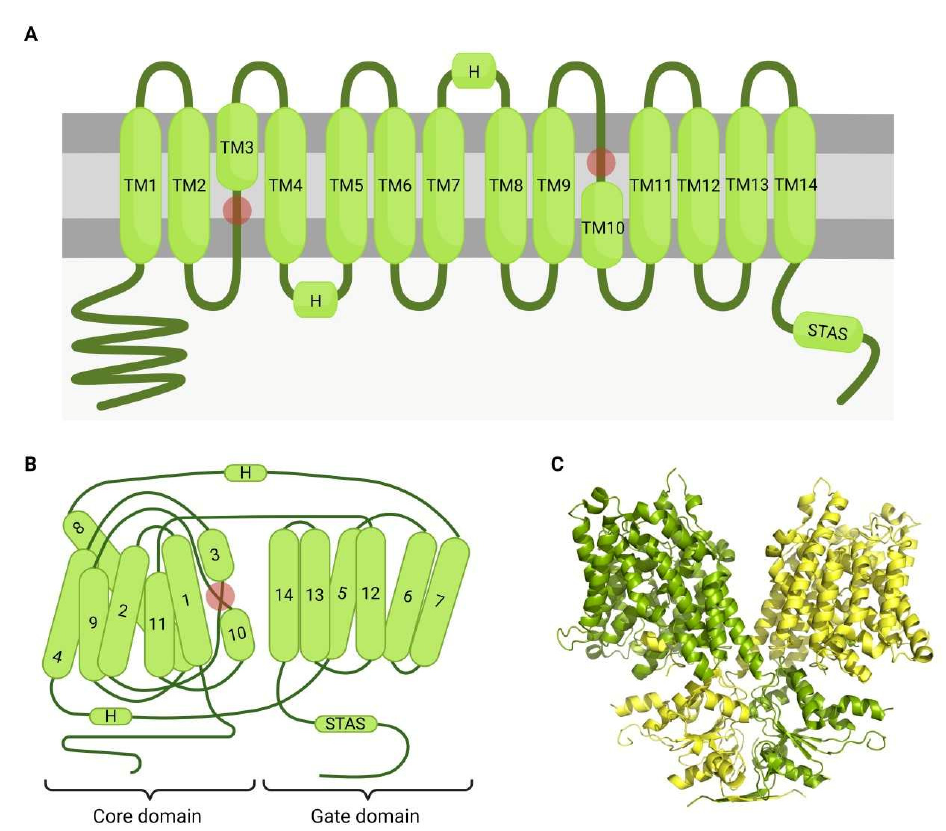
Figure 2. Structural characteristics of SLC26 channels. Bicarbonate exchangers from the SLC26 family present a highly similar structure to SLC4 channels. The structure presented in this figure corresponds to the SLC26A9 channel (PDB reference 7CH1). ( A ) SLC26 channels present 14 transmembrane α - helices (TM1–14) connected through loops that occasionally present amphipathic helices (H). TM3 and TM10 are two half-helices, and their N-termini regions form the active site (red circles). At the C-terminal region, a sulphate transporter anti-sigma factor antagonist domain (STAS), which is involved in SLC26 trafficking, and protein–protein interaction and regulation, which includes the interaction with the cystic fibrosis transmembrane conductance regulator channel (CFTR). ( B ) The folded protein conforms two different domains: the core domain, which is formed by helices TM1–4 and TM8–11; and the gate domain, which consists of TM5–7 and TM12–14. The N-termini of TM3 and TM10 face each other to form the active site (red circle). ( C ) SLC26 channels form dimers, with the STAS domain being excluded from the dimerization domain, since it must be free to interact with other